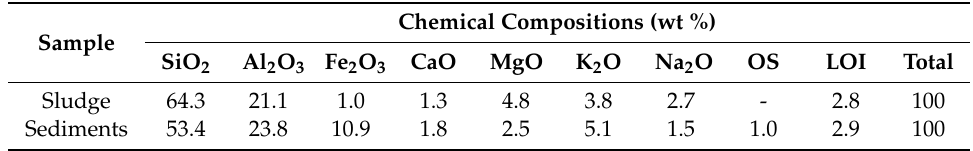
Table 4. Chemical composition of sludge and reservoir sediments.